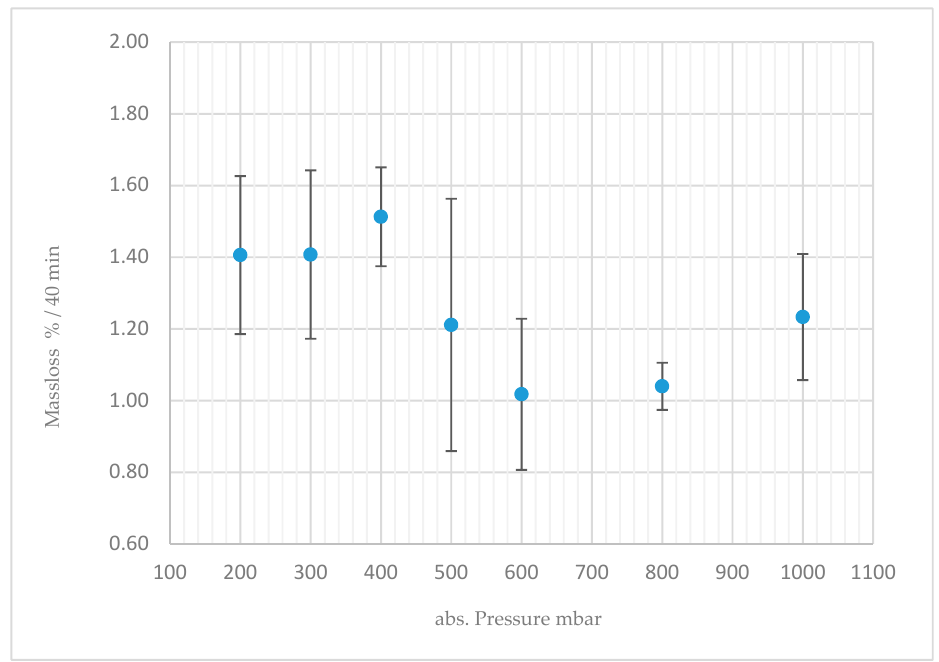
Figure 10. Volatility of 2.5 mg boric acid heated up to a temperature of 200 °C, as a function of absolute pressure [34].